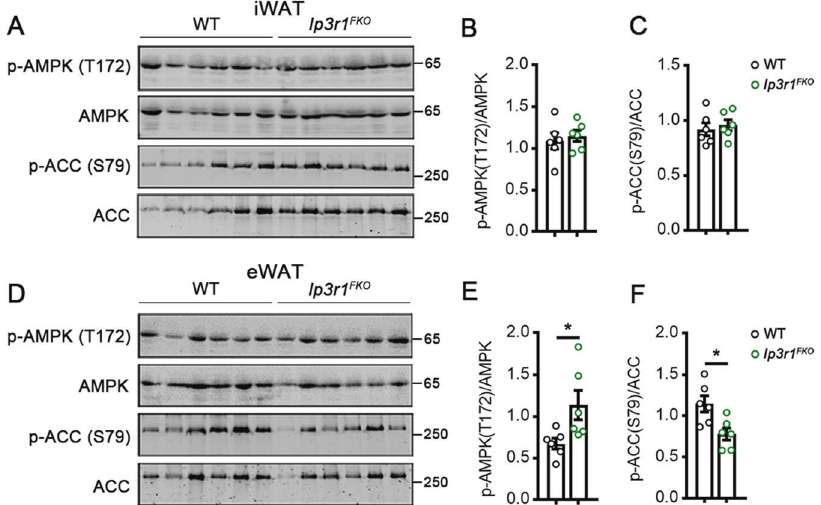
Fig. 7 Ip3r1 FKO mice showed activated AMPK signaling in white adipose tissues. Western blot analysis of p-AMPK (T172), p-ACC (S79), AMPK, and ACC in ( A – C ) iWAT and ( D – F ) eWAT lysates. Quanti fi cation of p-AMPK (T172)/AMPK and p-ACC (S79)/ACC was determined by ImageJ software ( n = 6). Data were analyzed by two-tailed unpaired Student ’ s t test and presented as means ± SEM. * P <